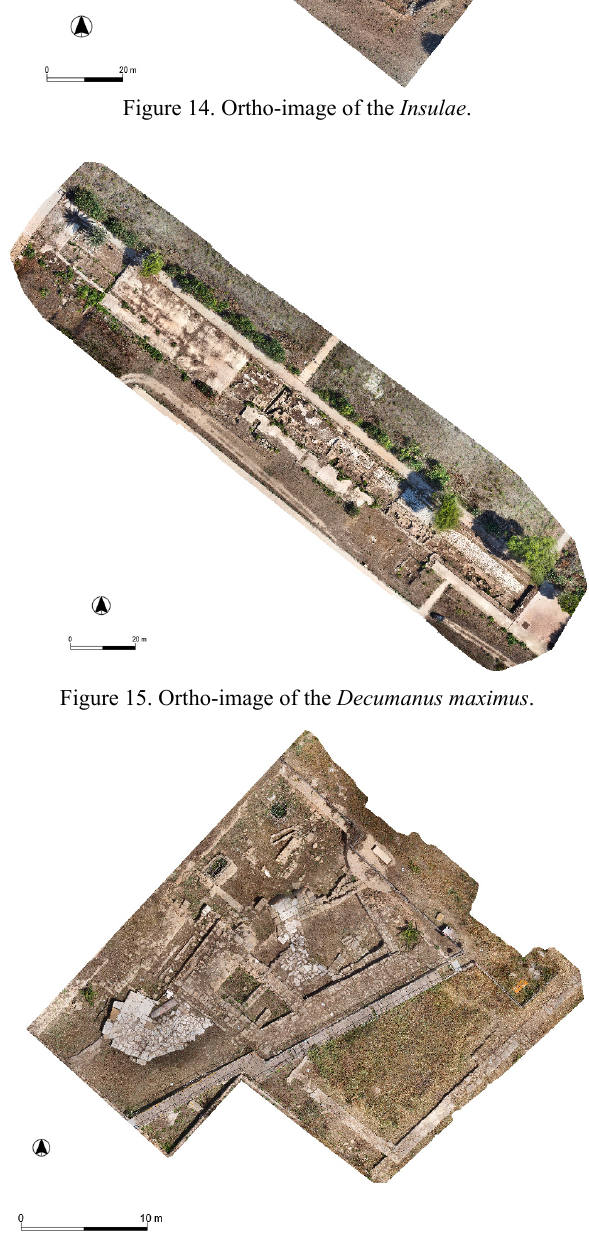
Figure 16. Ortho-image of the area of “San Giovanni”.